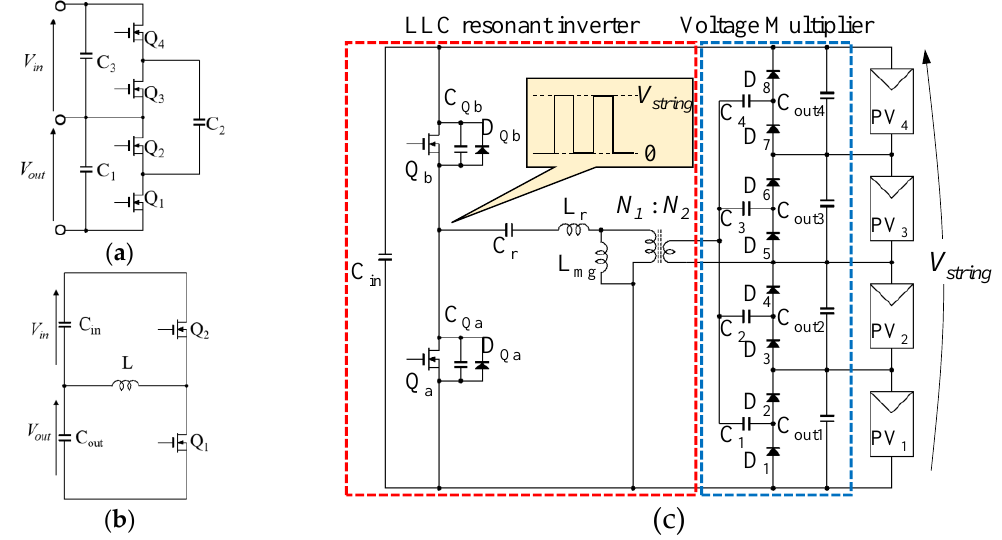
Figure 4. Key circuits for proposed DPP converter: ( a ) Switched capacitor converter (SCC); ( b ) Bidirectional PWM converter; ( c ) LLC resonant voltage multiplier